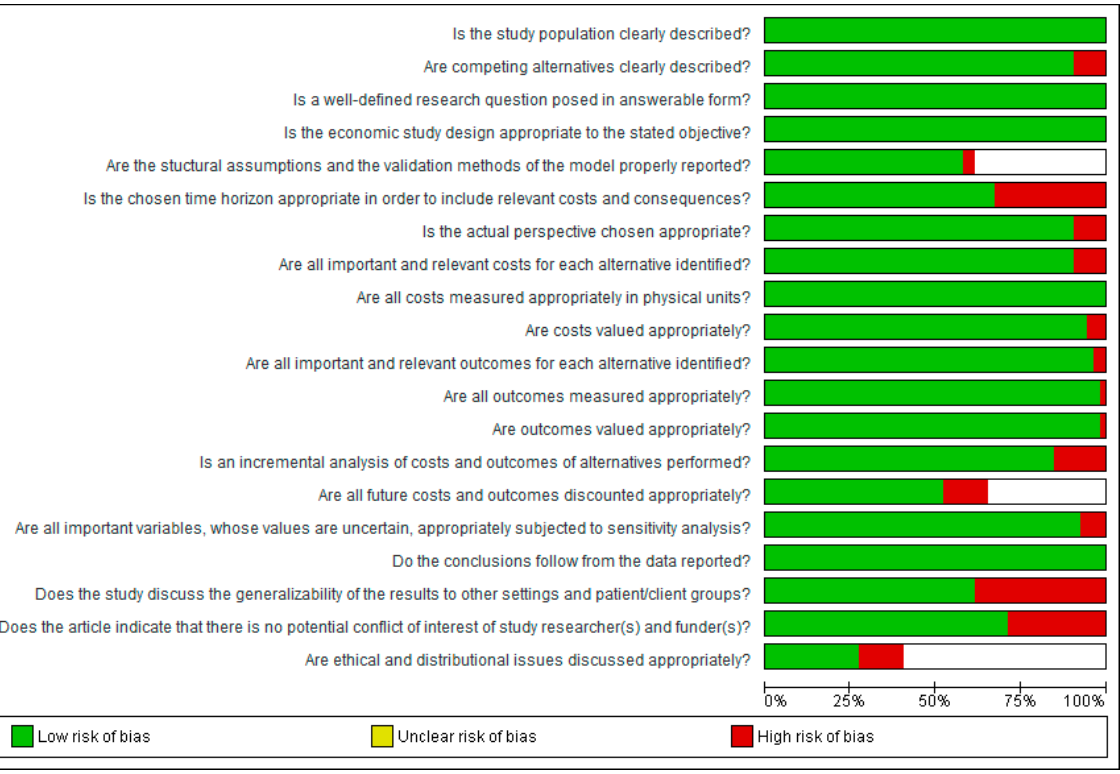
Figure A2. Review of authors’ judgments about quality assessment items in Consensus Health Economic Criteria (CHEC) extended list presented as percentages across all included studies.